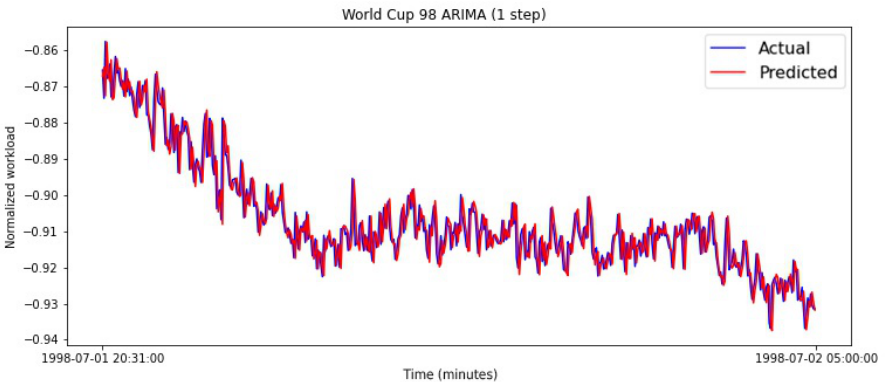
Figure 12. Bi-LSTM with one-step prediction on the testing set.